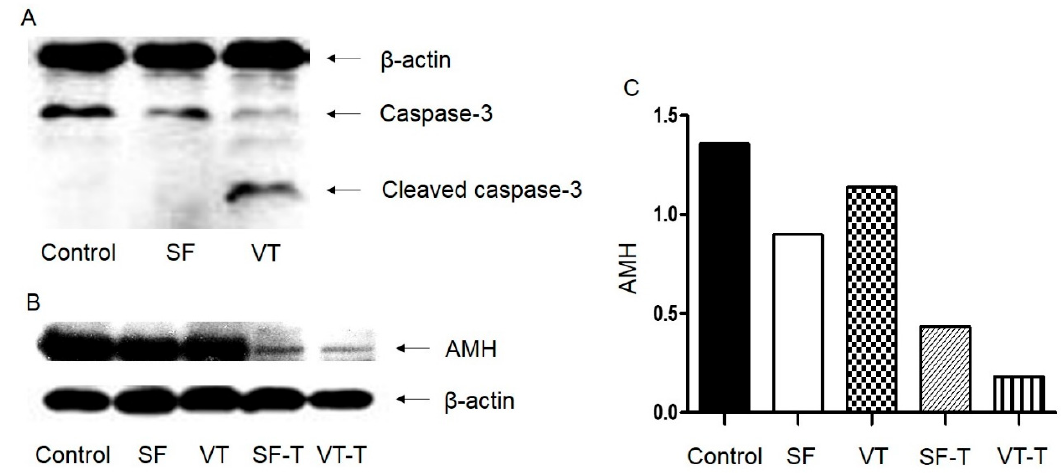
Figure 6. Western blot analysis to evaluate cell apoptosis based on caspase-3 expression ( A ) and anti-Müllerian hormone production by human ovarian tissues ( B , C ). Molecular weight: β -actin, 43 kDa; caspase-3, whole form, 35 kDa; caspase-3, cleaved forms, 19 kDa and 17 kDa; AMH, 60 kDa. Abbreviations: SF, cryopreserved with slow freezing technique and thawed group; VT, cryopreserved with vitrification technique and thawed group; SF-T, the group xenotransplanted after slow freezing and thawing; VT-T, the group xenotransplanted after vitrification and thawing; AMH, anti-Müllerian hormone.